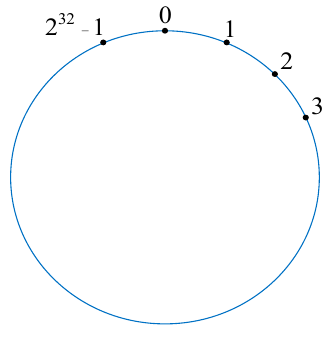
Figure 5. The designed hash circle.